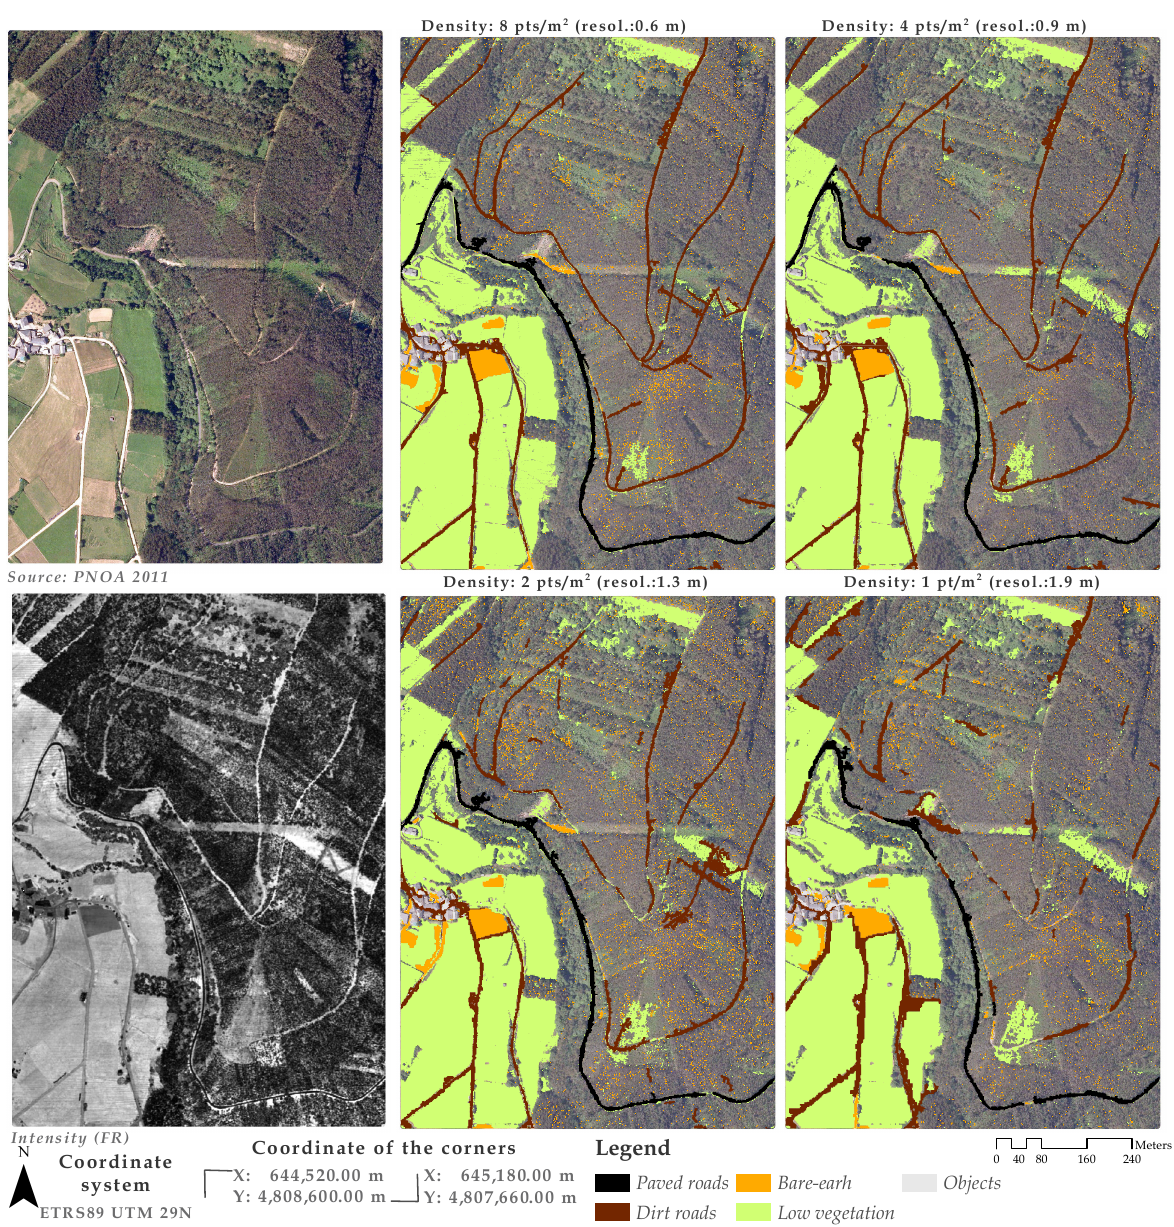
Figure 12. Hybrid classification results for point clouds with densities of 8, 4, 2 and 1 point/m 2